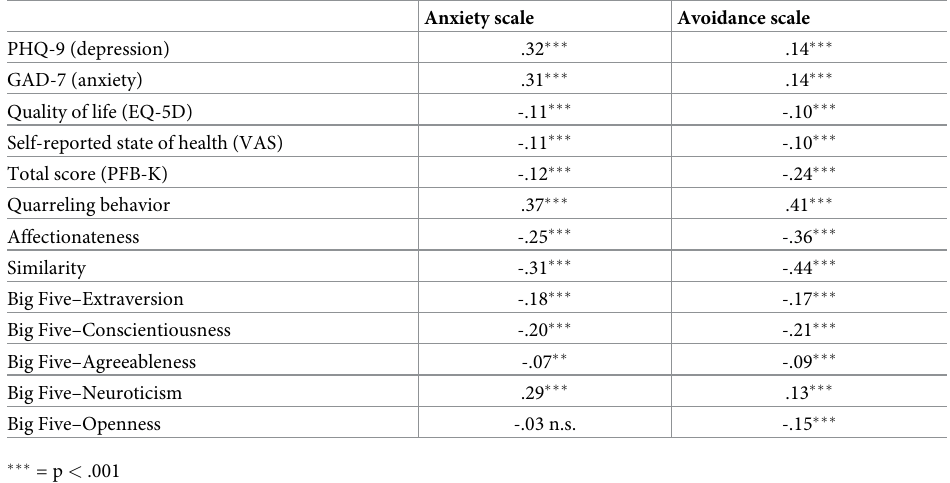
Table 7. Pearson correlations between ECR-S6 scales and further psychological scales.